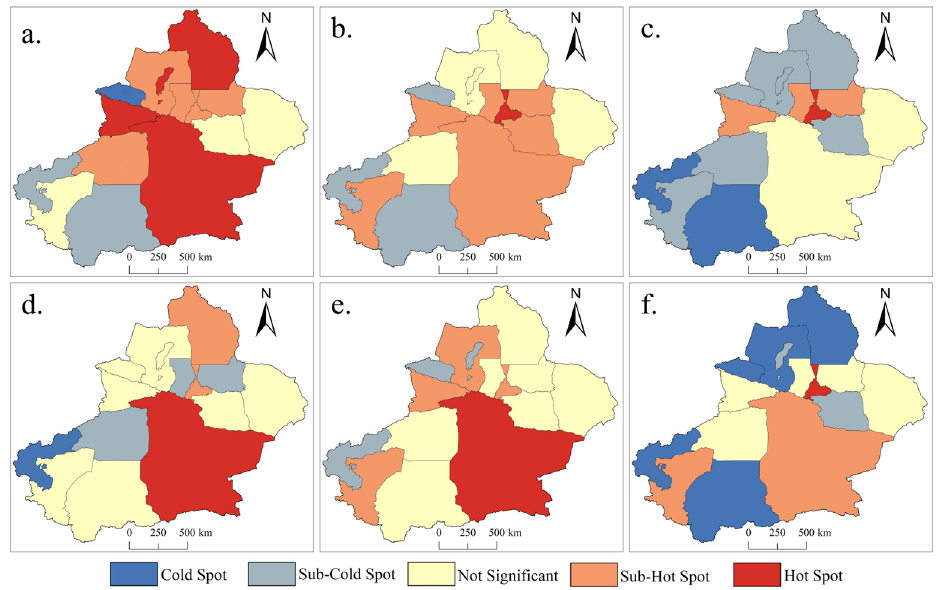
Figure 5. Analysis results of cold-spots and hotspots of different tourism resource categories in Xinjiang. ( a ) Geological landscape; ( b ) architectural landscape; ( c ) biological landscape; ( d ) water landscape; ( e ) entertainment and shopping; ( f ) site ruins.